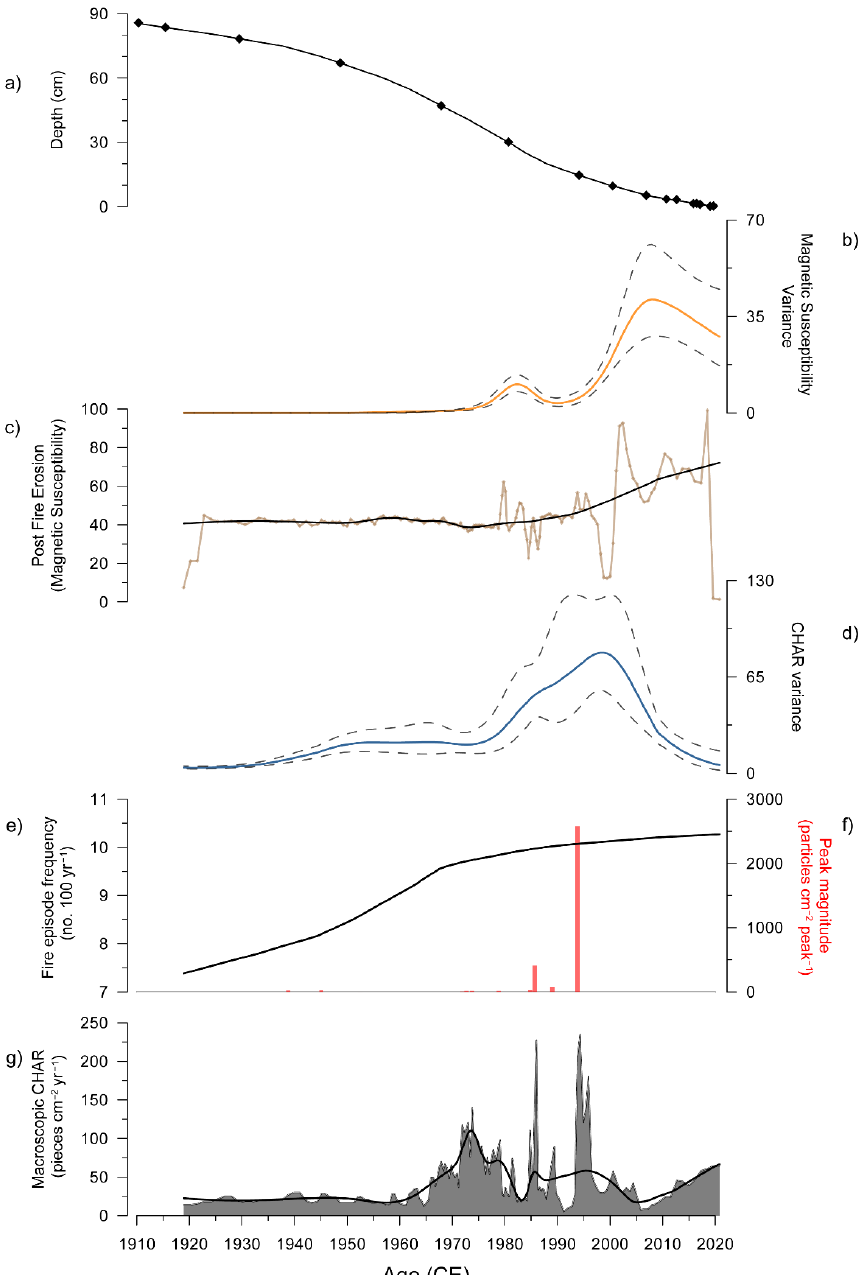
Figure 5. Results ( a ) Age-depth model (black line) with dating control points marked as black diamonds; ( b ) Magnetic susceptibility generalized additive model (GAM) fitted variance (orange line) and confidence intervals (grey dashed lines); ( c ) The magnetic susceptibility profile from core VIC2104A (brown line) with a GAM (black line); ( d ) CHAR GAM fitted variance (blue line) and confidence intervals (grey dashed lines); ( e ) Fire episode frequency (black line) (window-width = 100 years; note this is the minimum window width applicable) (CharAnalysis); ( f ) Peak magnitude (particles cm − 2 peak − 1 ), which measures fire size and intensity (red bars) (Char- Analysis); ( g ) Macroscopic charcoal accumulation rate (Macroscopic CHAR, pieces cm − 2 yr − 1 ) (grey) (window-width = 100 years) with a GAM (black line). For interpretation of the references to colour in this figure legend, the reader is referred to the web version of this